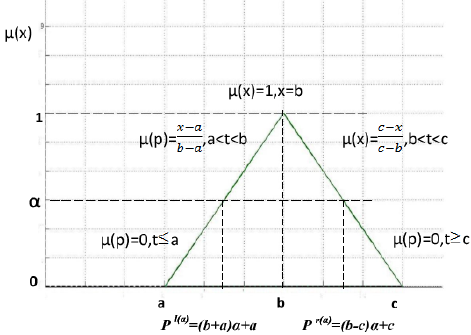
Fig. 1. Membership function development for fuzzy linguistic